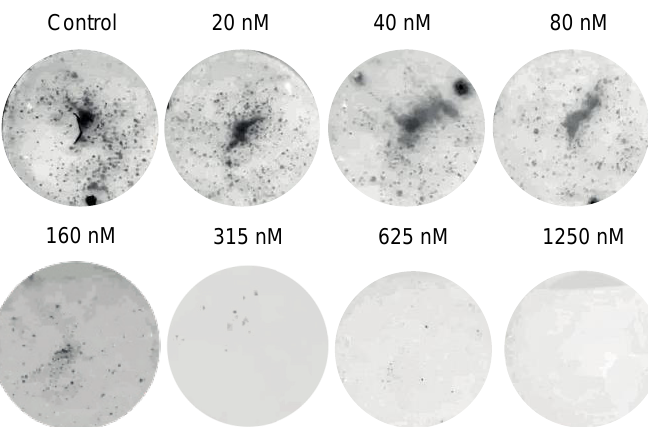
Figure 3. VLX600 led to decreased spheroid growth of MYCN-amplified neuroblastoma. ( A ) IMR-32 derived spheroids exposed to the indicated concentrations of VLX600 for 72 h. Every 24 h, pictures under each condition were recorded ( n = 5). Dead cells will gradually separate from spheroids after VLX600 treatment. The circles (white) indicate the remaining part of spheroids, assisting for the diameter measurement and spheroids volume calculation. ( B ) Quantification of residual spheroid volume in cells exposed to the indicated concentrations of VLX600. 1250nM # : a remaining part of spheroid was still observed in ( A , B ), however, no colony was generated under the same condition ( D ), indicating that the assessment of the percentage of viable cells after VLX600 cannot solely depend on the remaining volume of spheroids. ( C ) Hematoxylin staining for spheroids treated with either DMSO or 200 nM VLX600 for 72 h. ( D ) Colony formation assay for 10 days for cells from the spheroids treated with either DMSO and VLX600. ( E ) Quantifications of colony formation assay ( n = 2, two repeats). The p values for statistical significance were determined using a t -test, * p < 0.05 and *** p < 0.001.